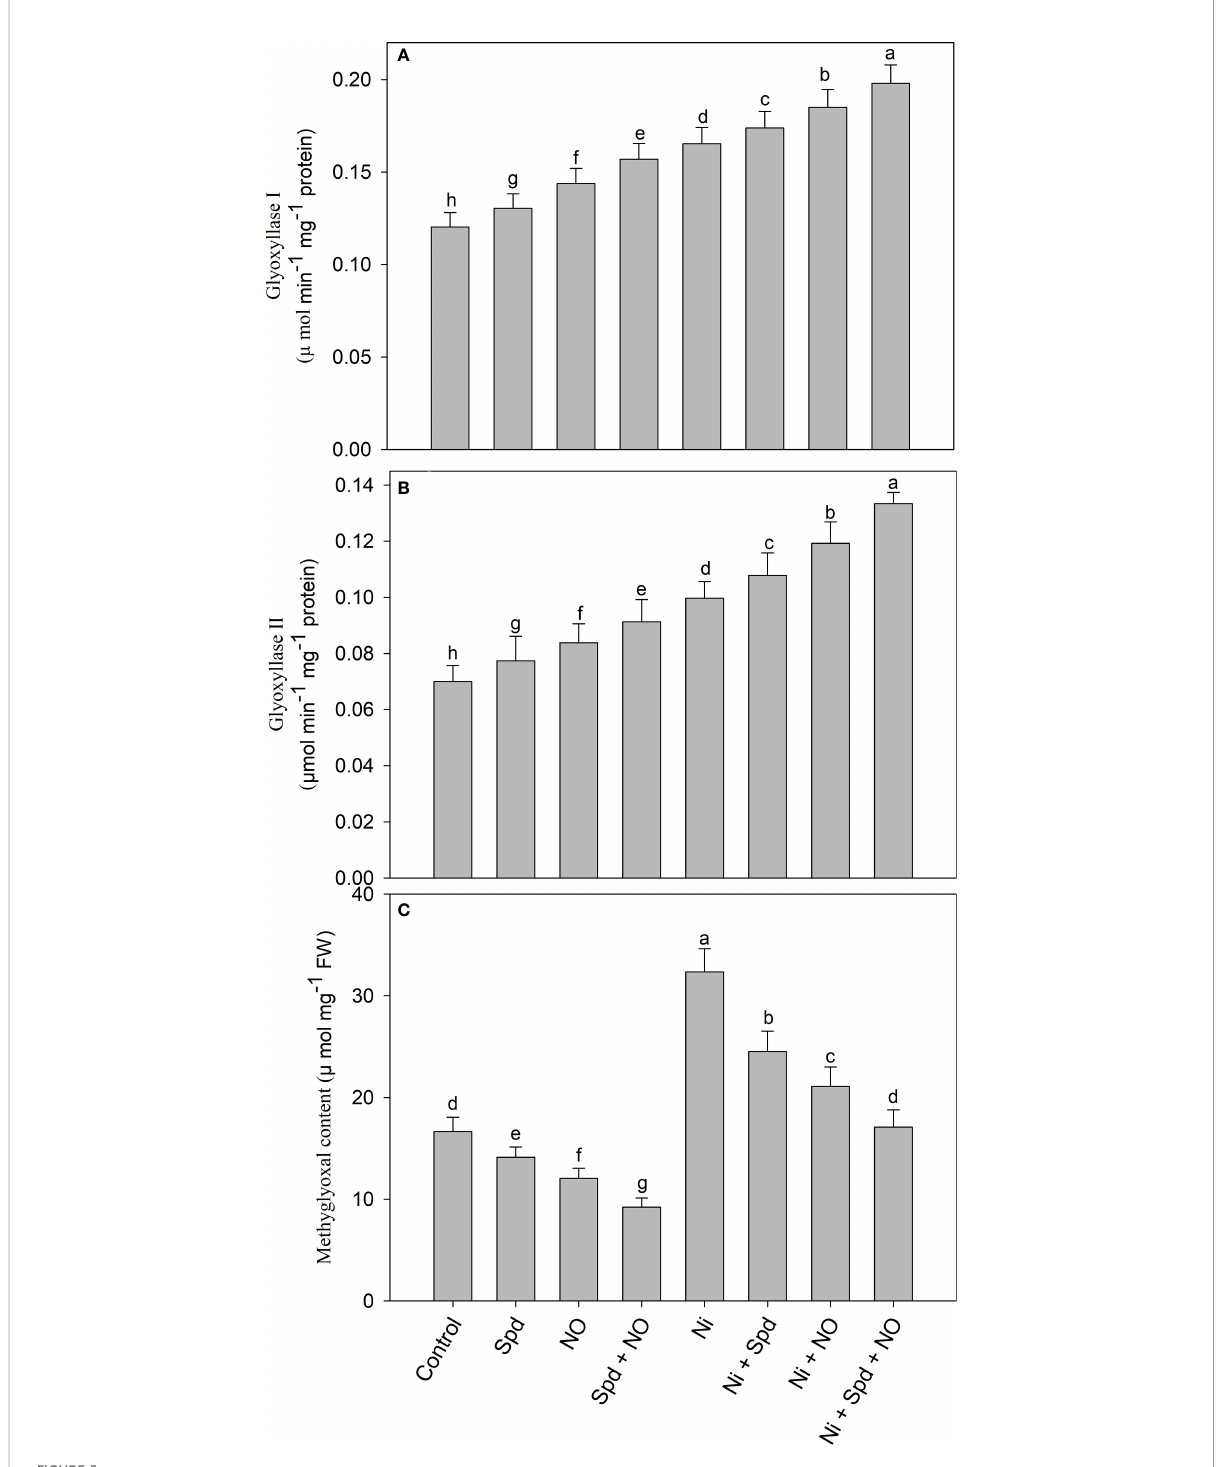
FIGURE 5 Effect of nitric oxide (50 µM) and spermidine (100 µM) supplementation on (A) activity of (A) glyoxylase I, (B) glyoxylase II and (C) methylglyoxal content in Solanum lycopersicum L. subjected to nickel stress. Data is mean (±SE) of four replicates and different letters on bars denote signi fi cant difference at P <